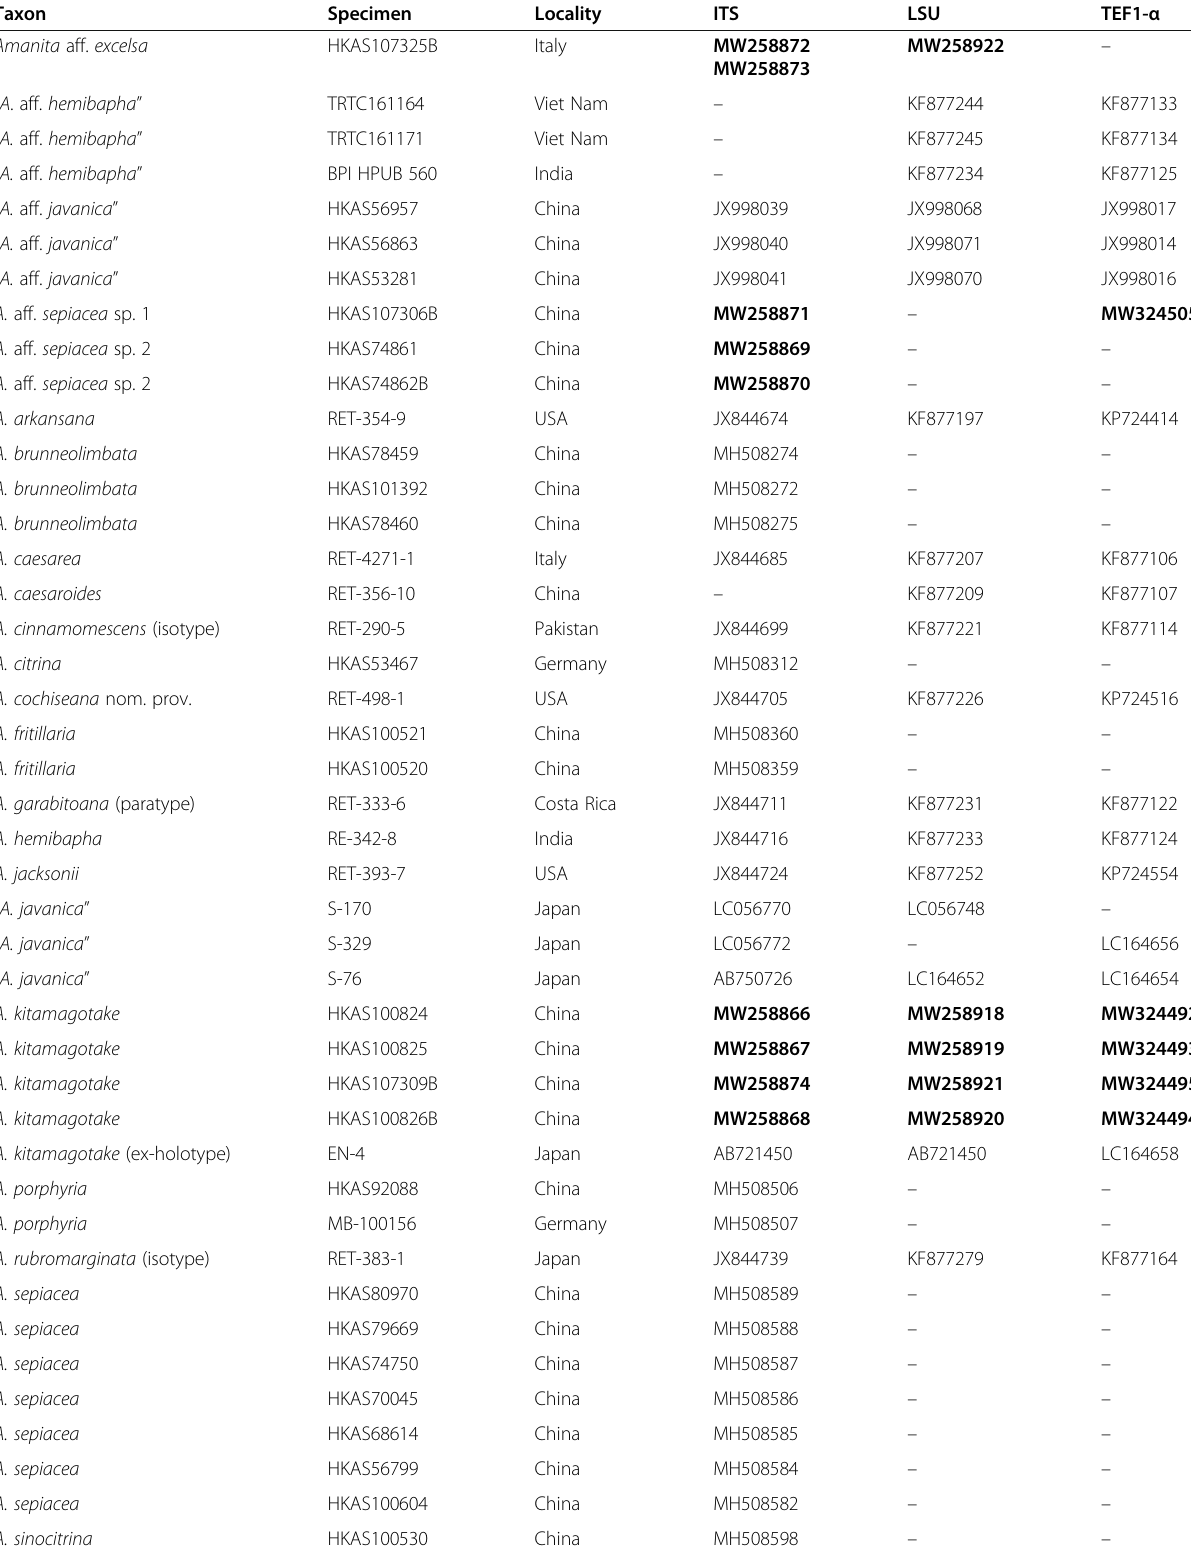
Table 2 Specimens used to identify the mycocecidia of new species of Squamanita in this study are listed with their Herbarium ID and accession numbers. Newly generated sequences are highlighted in boldface